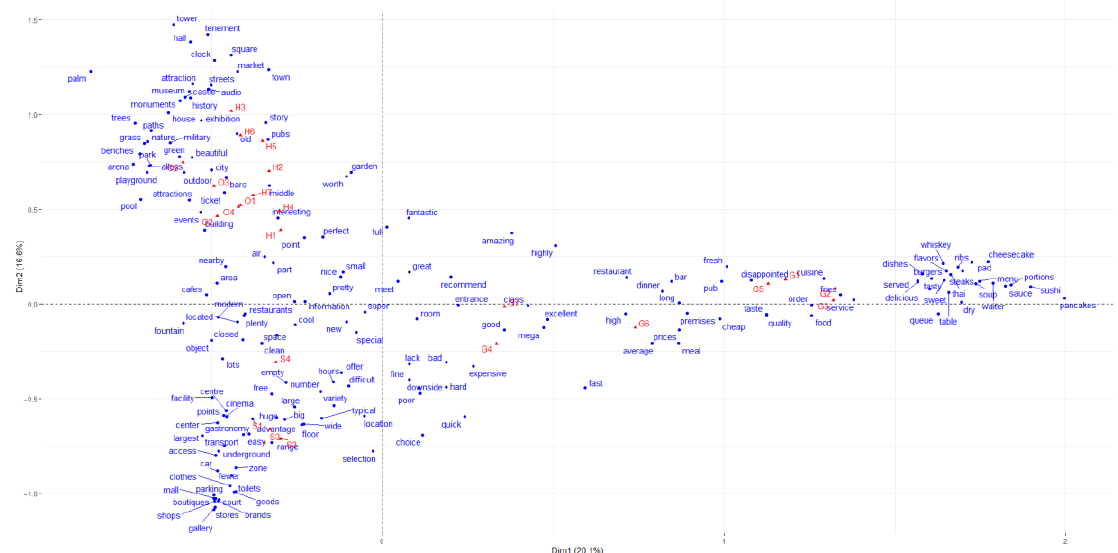
Figure 2. Correspondence analysis of terms associated with place attributes dimension and places selected for the study. Red labels represent analyzed places; Blue labels represent keywords associated with shown at the figure place experience dimension. The x -axis and y -axis indicate percent of variance